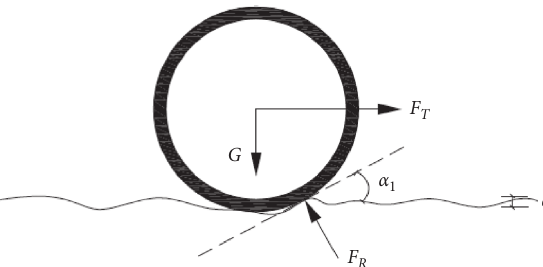
Figure 1: Road surface-wheel mechanical